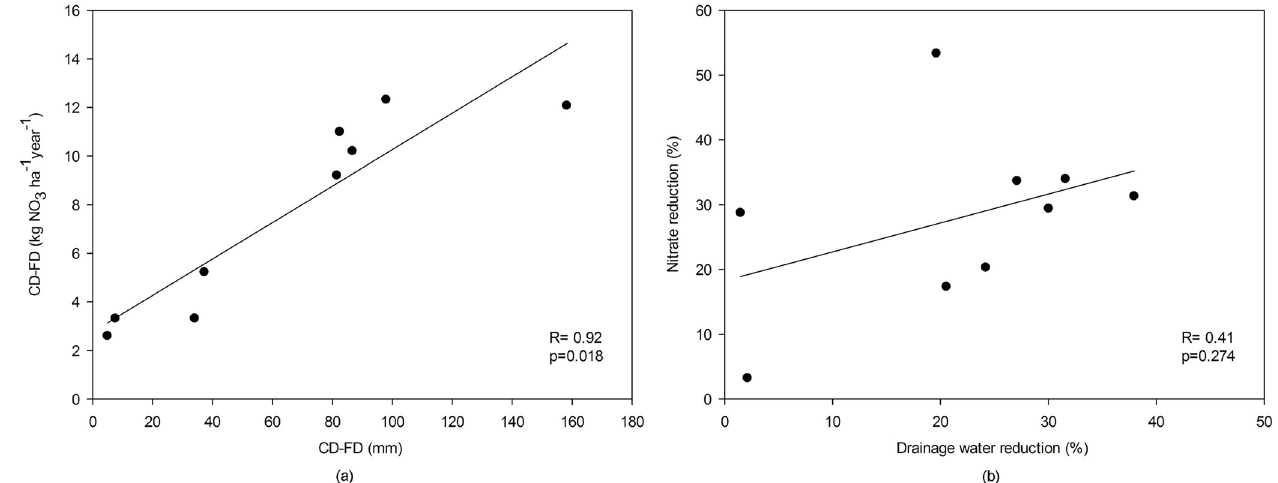
Fig 10. Absolute (a) and relative (b) reduction of nitrate versus absolute and relative reduction of drainage water with controlled